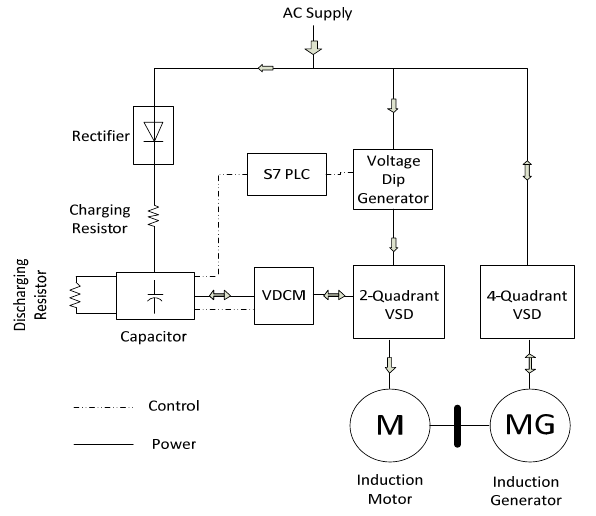
Figure 10. Block diagram of experimental set-up.